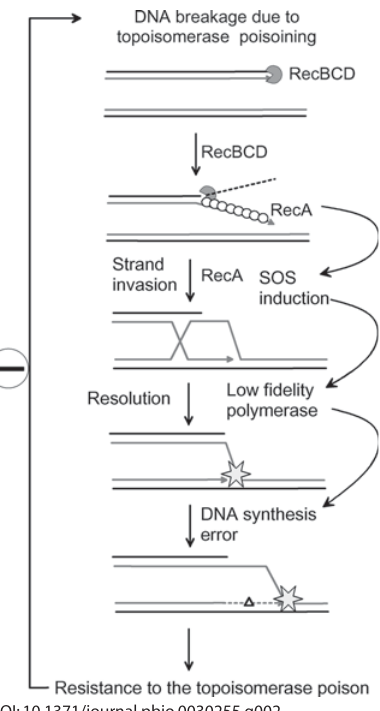
Figure 2. A Model for SOS-Dependent Evolution to Antibiotic Resistance Topoisomerase poisoning agents cause DNA double-strand breaks. RecBC in turn loads RecA. RecA fi laments induce the SOS response and recombine. The homologous recombination reaction ends with a primer-template structure to which SOS-induced polymerases have access. DNA synthesis by these low-fi delity polymerases is accompanied by the introduction of mutations. A sub-population of mutant cells that can resist the poisoning agent invade the niche. The break-induced erroneous repair model, originally proposed for the mutagenic effects of DNA double-strand breaks in various laboratory conditions, accounts for the emergence of ciprofl oxacin- resistant bacteria in a murine infection model [18]. Indented circles, RecBC; stars, SOS-induced DNA polymerases; triangle, mutation; white circles,